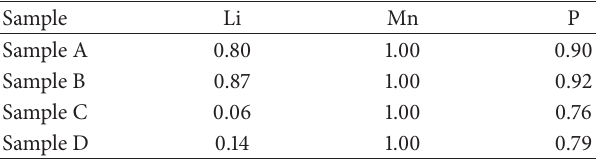
using various 4